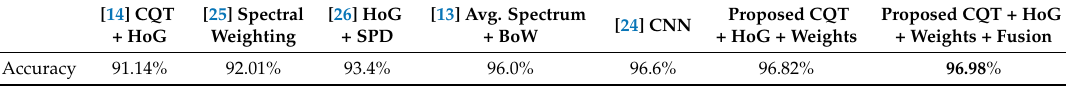
Table 2. Performance comparison on the LITIS Rouen